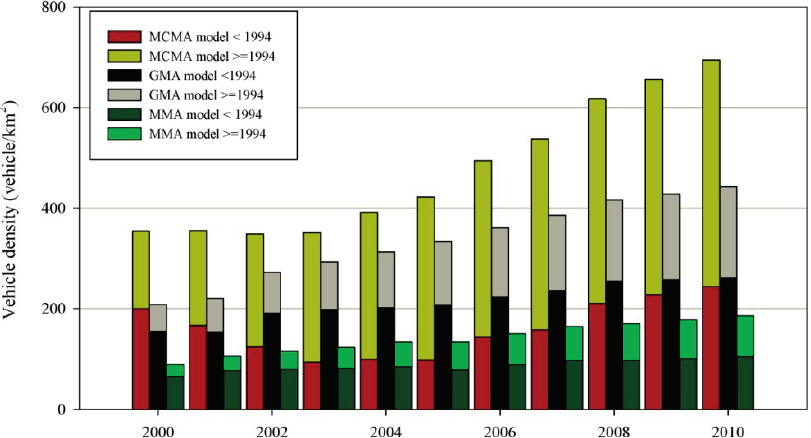
Figure 4. Distributions of vehicles by model year in the MCMA, GMA, and MMA